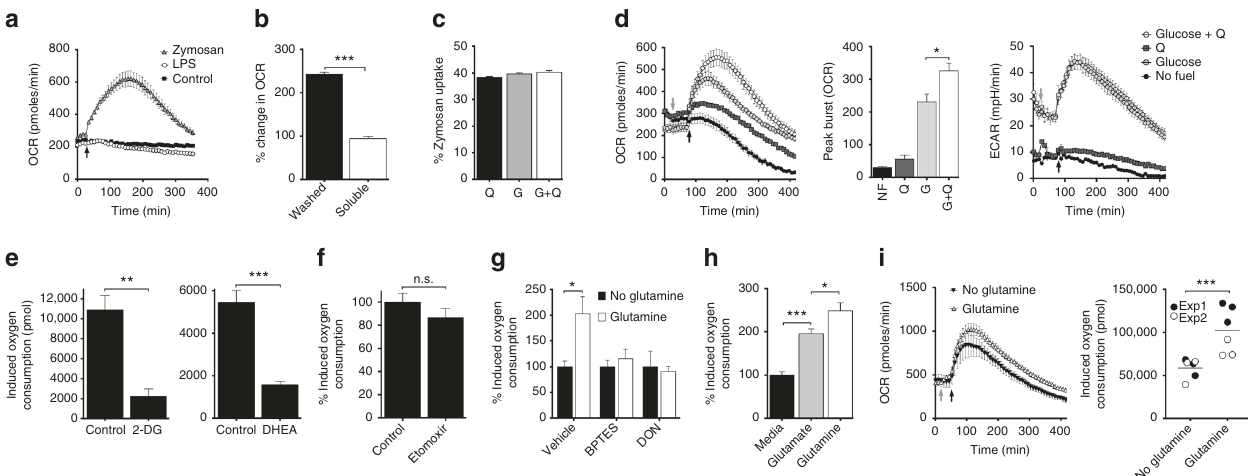
Fig. 3 Peritoneal tissue-resident macrophages enhance their respiratory burst with glutaminolysis. a Line graph showing oxygen consumption rate (OCR) in peritoneal tissue-resident macrophages (pTRMØ). Arrow = zymosan (50 μ g/ml), LPS (100 ng/ml) or control. b OCR changes in pTRMØ with washed particle- or soluble-zymosan components. Data were analysed by Student ’ s t -test. c Quanti fi cation of pTRMØ uptake of pHrodo zymosan (50 μ g/ml,1 h). G = glucose (25 mM), Q = glutamine (2 mM). Data were not signi fi cant by one-way ANOVA ( p = 0.0756) with Tukey ’ s post-tests. d OCR or extracellular acidi fi cation rate (ECAR) vs time in pTRMØ. Cells were starved from glutamine (Q) and cultured ± glucose before addition of Q or control (grey arrow). Zymosan = black arrow. Peak burst is quanti fi ed in the chart and analysed by one-way ANOVA ( p < 0.0001), signi fi cant Tukey ’ s post-tests for Q addition are shown. e Graph showing the total oxygen consumption of pTRMØ after zymosan, quanti fi ed from OCR vs time (as in d ), in the presence of 2- deoxyglucose (2-DG, 100 mM), dehydroepiandrosterone (DHEA,100 μ M) or vehicle. Data were analysed by Student ’ s t -test. f Graph showing the percentage oxygen consumption of pTRMØ after zymosan in the presence of etomoxir (50 μ M) or vehicle. Data are pool of two experiments ( n = 6 – 7) and were analysed by two-way ANOVA (interaction p = 0.376, etomoxir p = 0.2588). g Relative total oxygen consumption after zymosan of pTRMØ